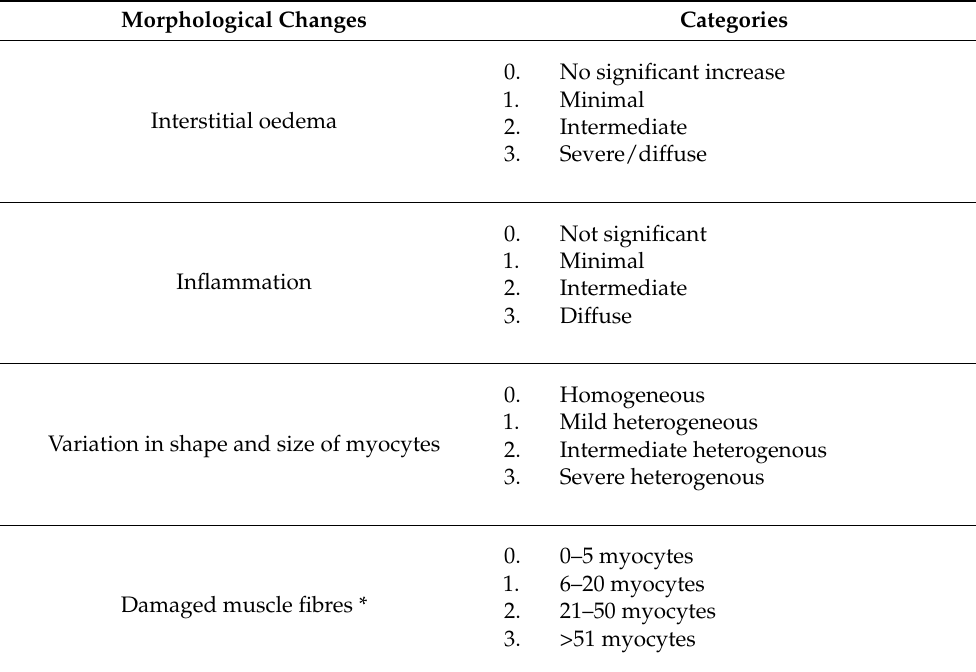
Figure 2. Morphological features of degenerative muscle fibres due to ischemia-reperfusion injury in transverse muscle sections stained with H&E at 12 h after flap replantation. Upper left: variation in muscle fibre shape and size. Oedema and inflammation are also seen. Upper right: hypoxic myocyte (rounded and hypereosinophilic). Lower left: neutrophil influx in the myocyte. Lower middle: necrotic, pale fibres and phagocytized myocytes. Lower right: Masson’s trichrome staining, fibrotic myocytes are stained green. Table 2. Proposed histologic scoring system for hypoxia-induced muscle tissue injury in extracorpo- real perfusion